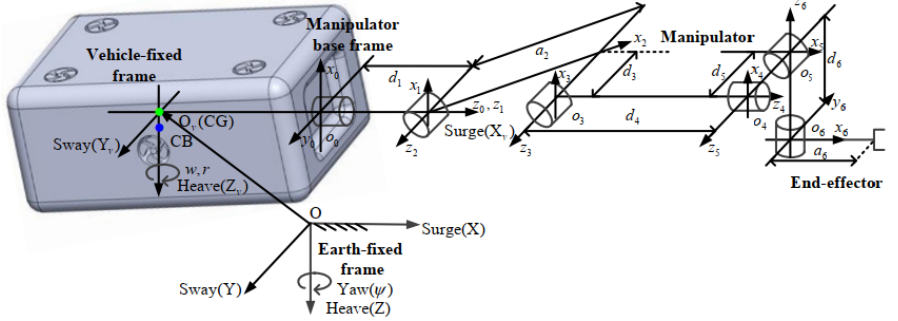
Figure 4. The coordinated frames of the ten DOF UVMS. Table 2. The model parameters and hydrodynamic coefficients of the underwater vehicle.